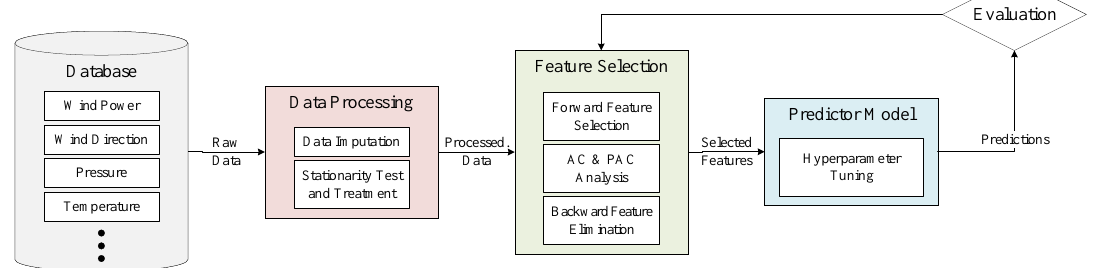
Figure 4. Schematic of wind prediction procedure.